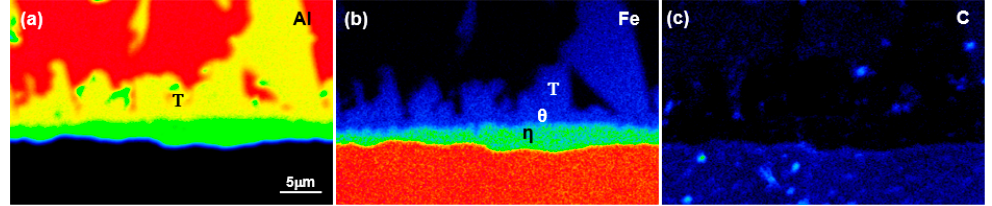
Figure 13. Electron probe micro-analysis (EPMA) area analysis near the reaction layer: ( a ) Al, ( b ) Fe, and ( c ) C.